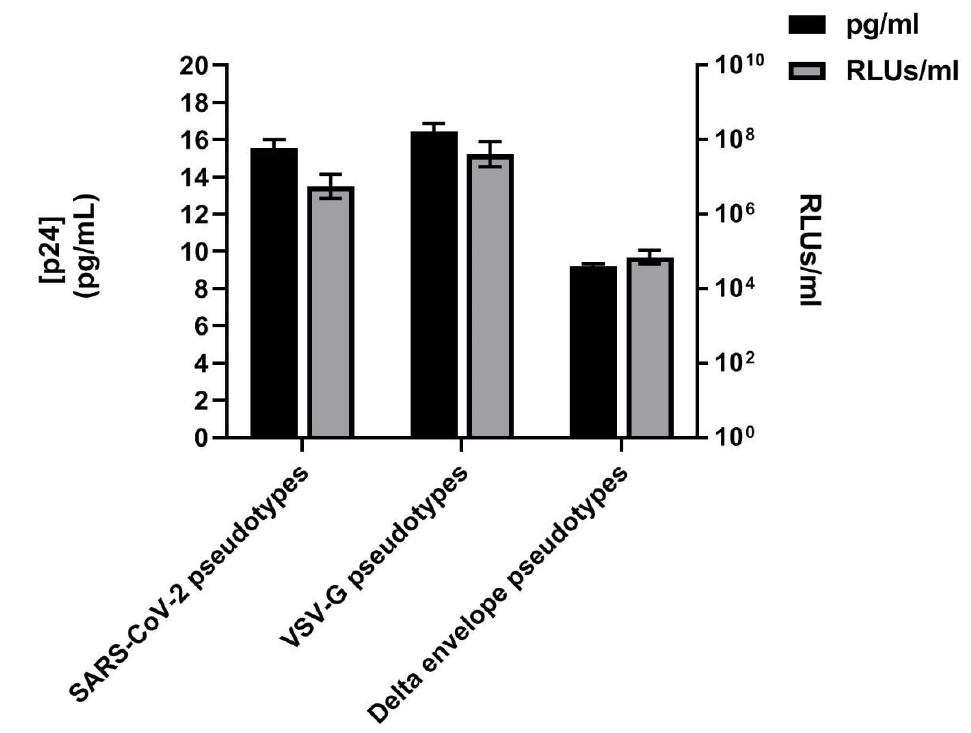
Figure 3. p24 quantification. Vector particle concentration (pg p24 protein per mL) determined by p24 ELISA and corresponding lentiviral vector infectivity (RLUs / mL). Values expressed as the means ± SD of independent measurements ( n = 8).